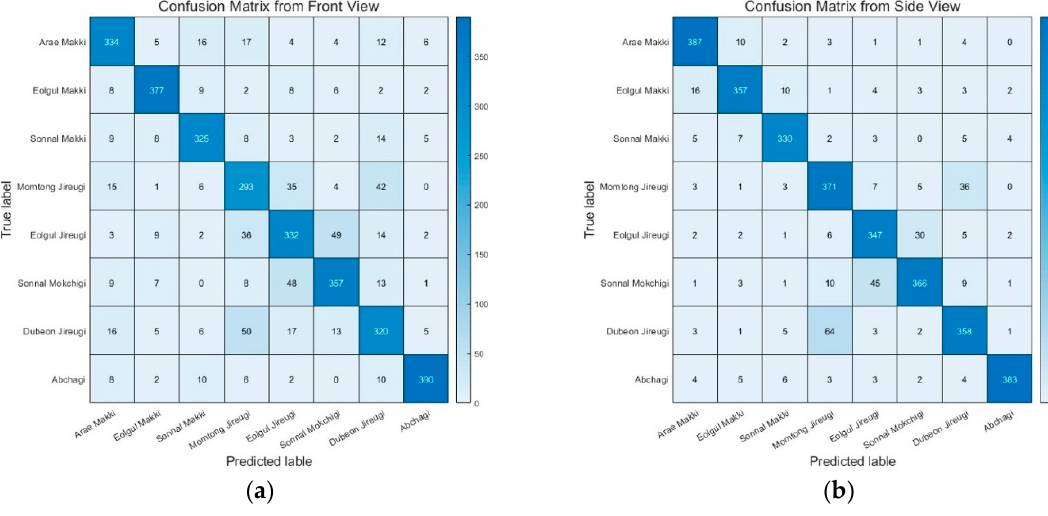
Figure 14. Confusion matrices of the cumulative test results: ( a ) front view and ( b ) side view.